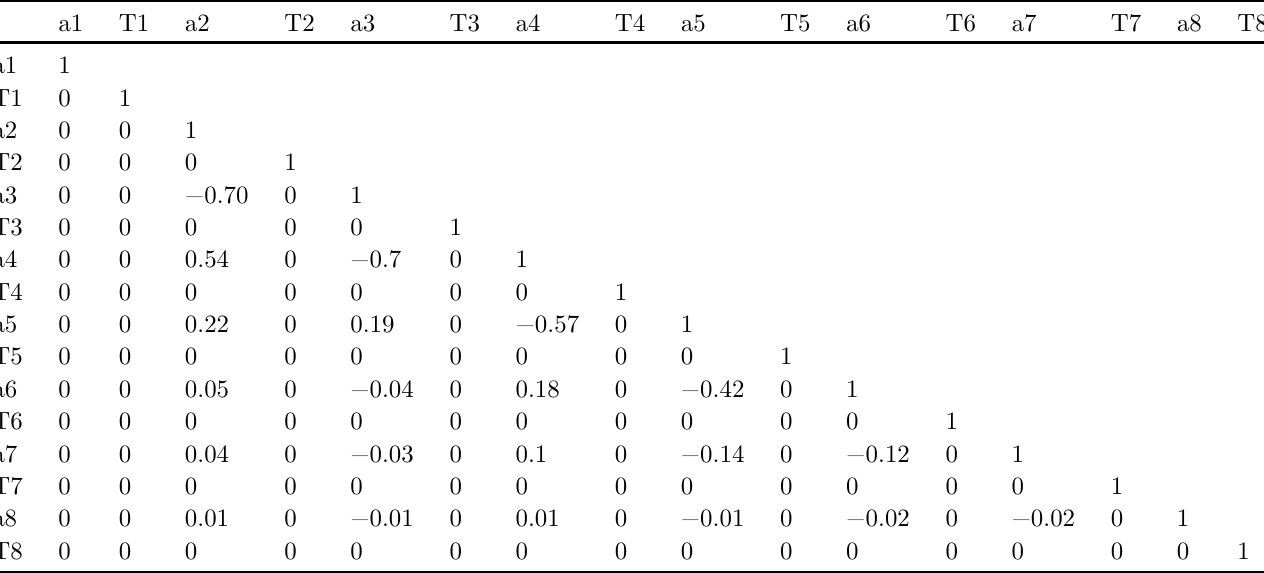
Table 5. The 8-group correlation matrix obtained in processing of the experimental decay curve measured from fi ssion of 235 U by thermal neutrons.